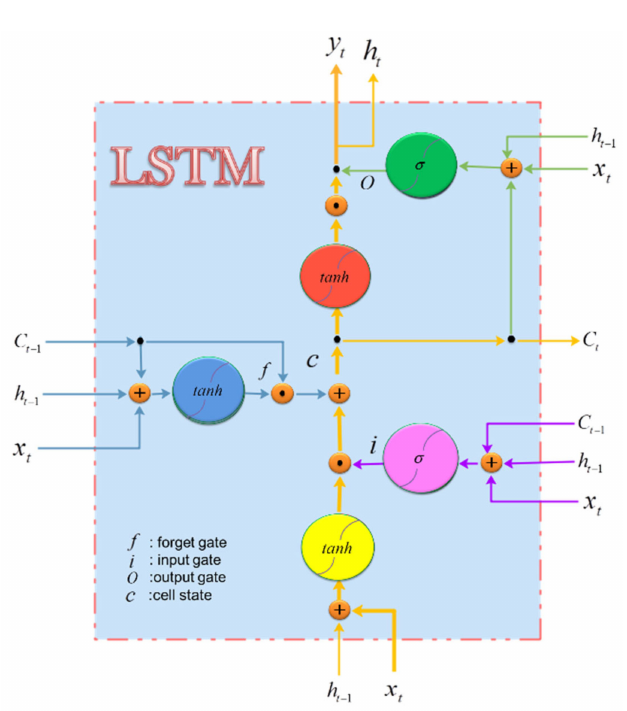
Figure 1. Flowchart of the long short-term memory neural network (LSTM)